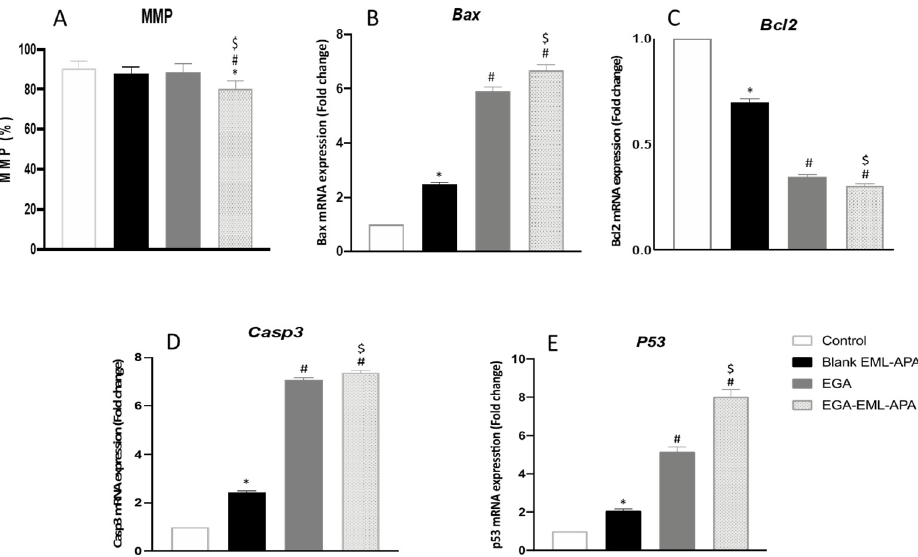
Figure 11. Effect of the EGA-EML-APA on MMP in MCF-7 cells. ( A ), the mRNA expression on Bax ( B ) , Bcl2 ( C ) , Casp3 ( D ) , P53 ( E ). Data are presented as Mean ± SD (n = 3). *, # or $: Statistically different from control, blank EML-APA or EGA, respectively at p < 0.05. Abbreviations: EGA, ellagic acid; EML, emulsomes; APA, apamin.